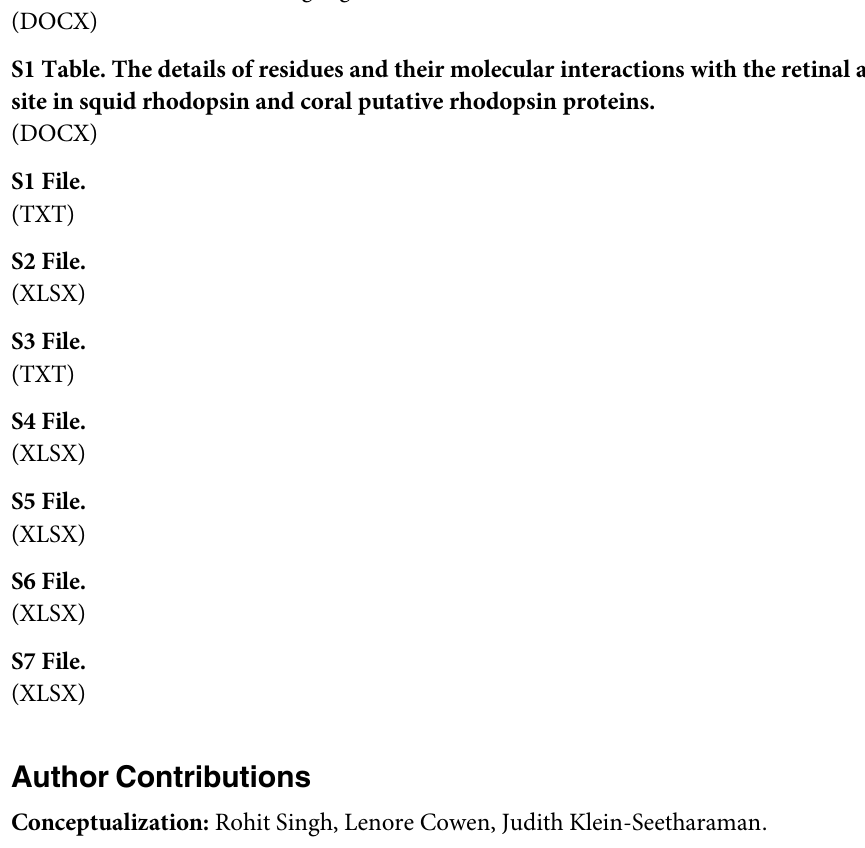
S1 Fig. Clustal omega multiple sequence alignment of opsin homologs. Residues involved in active site formation are highlighted in blue. S1 Table. The details of residues and their molecular interactions with the retinal active site in squid rhodopsin and coral putative rhodopsin